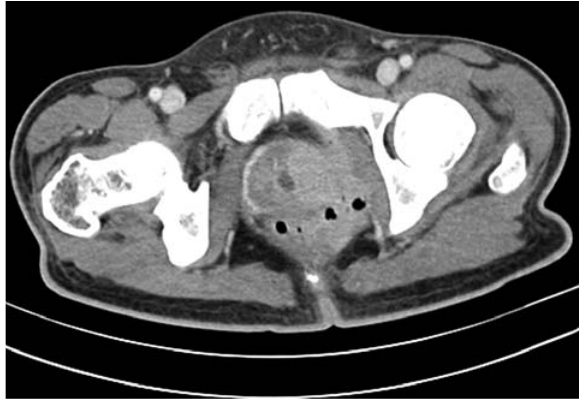
Figure 2 – CT scan showing prostatic abscess ruptured into left ischiorectal